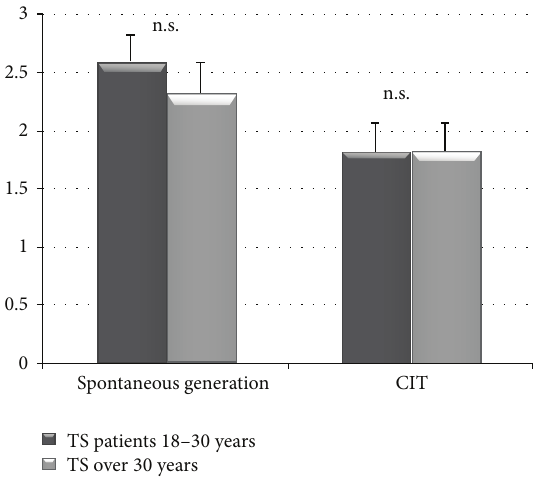
Figure 2: Correct responses produced by under 30-year-old and over 30-year-old TS patients in spontaneous counterfactual genera- tion test and counterfactual inference test